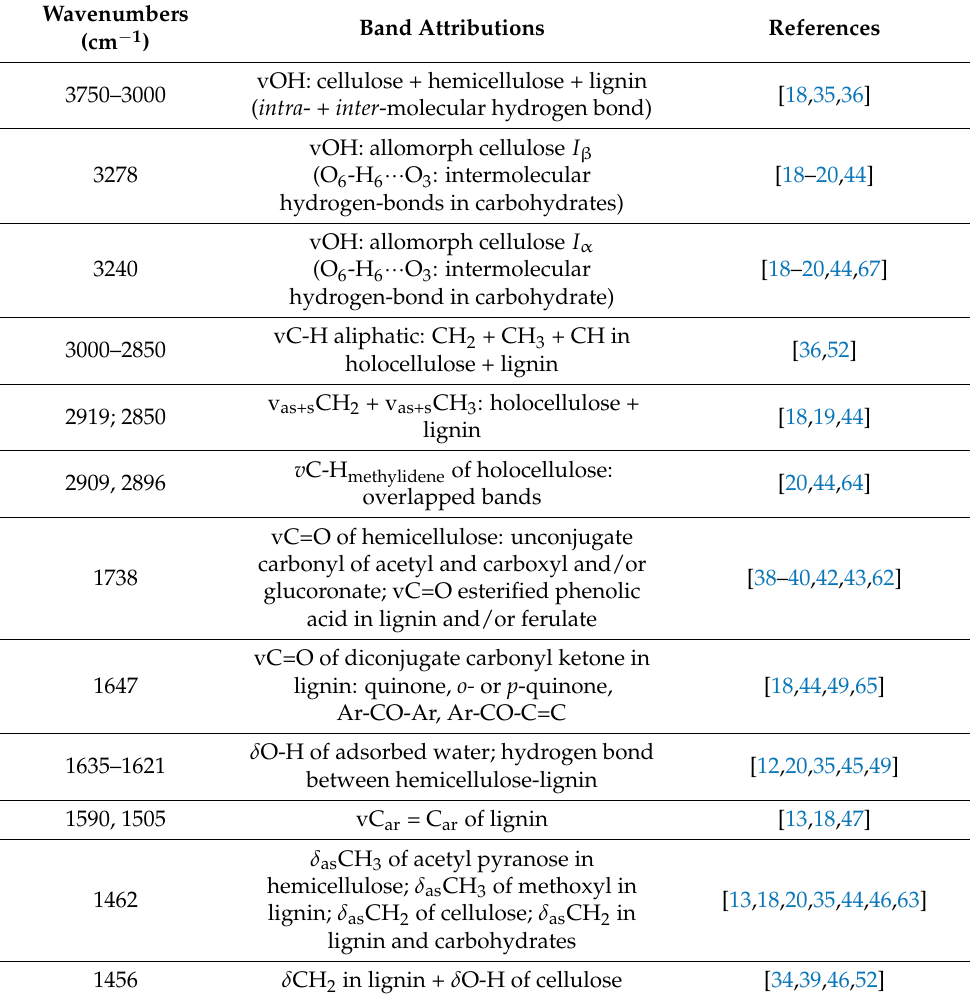
Table 2. Assignments of IR bands for the cedar softwood samples. Wavenumbers Band